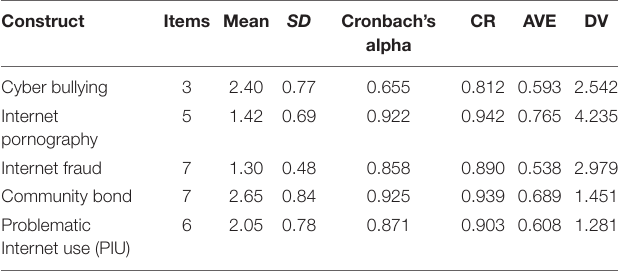
TABLE 2 | Validity and reliability.